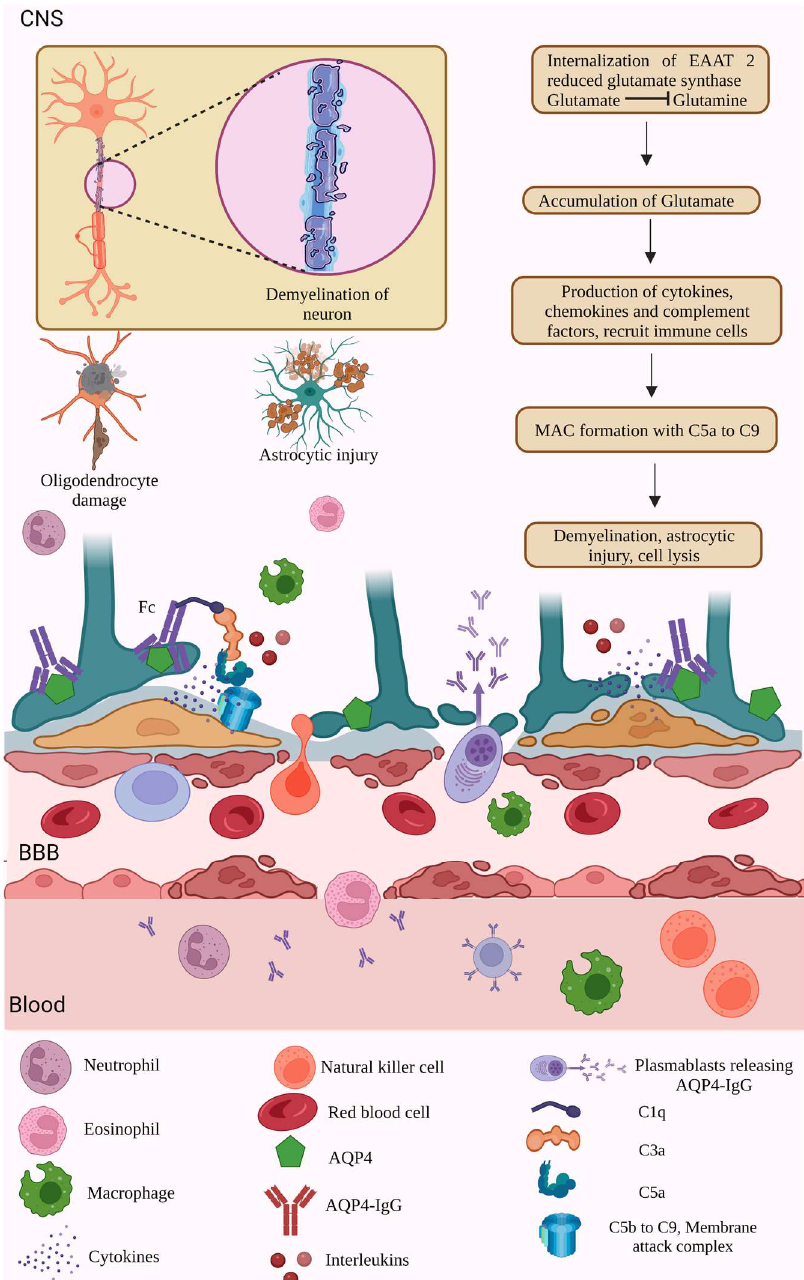
Figure 3. AQP4- dependent NMOSD pathology. NMOSD pathogenesis is initiated through various etiological factors such as genetic reasons, environmental factors, genetic-environment context, low levels of vitamins, medications, and so on. NMOSD pathogenesis involves the synthesis of autoantibodies against AQP4, a water channel transmembrane protein present in the astrocyte end feet of the BBB. AQP4 antibodies moved from the plasma into the CSF through the BBB. The presence of more AQP4 autoantibodies circulating in the plasma results in inflammation and causes the